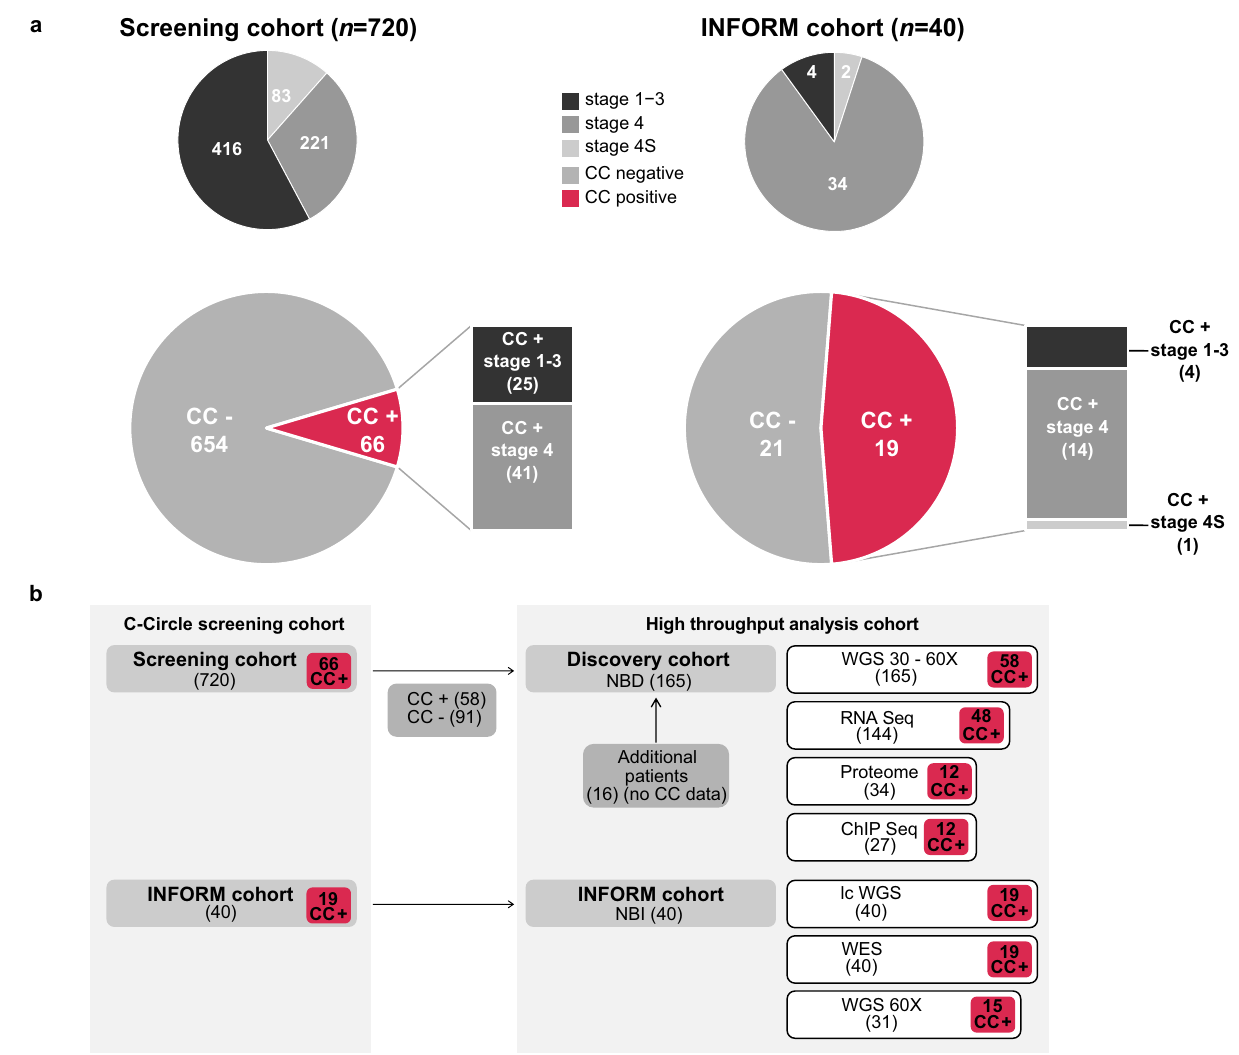
Fig. 1 C-Circle screening of neuroblastomas. a ALT frequency detected using C-Circle presence as a marker in the screening cohort ( n = 720, left) and INFORM cohort ( n = 40, right). Top pies illustrate the composition of the cohorts concerning INSS tumor stage. b Schematic overview of the analyzed patient cohorts used for C-Circle screening and high-throughput analysis using whole genome sequencing (WGS), RNA-sequencing, whole proteome analysis, and ChIP-sequencing. Sample numbers are given in brackets. Number of C-Circle positive (CC + ) and C-Circle negative (CC-) patients in the sub- cohorts are